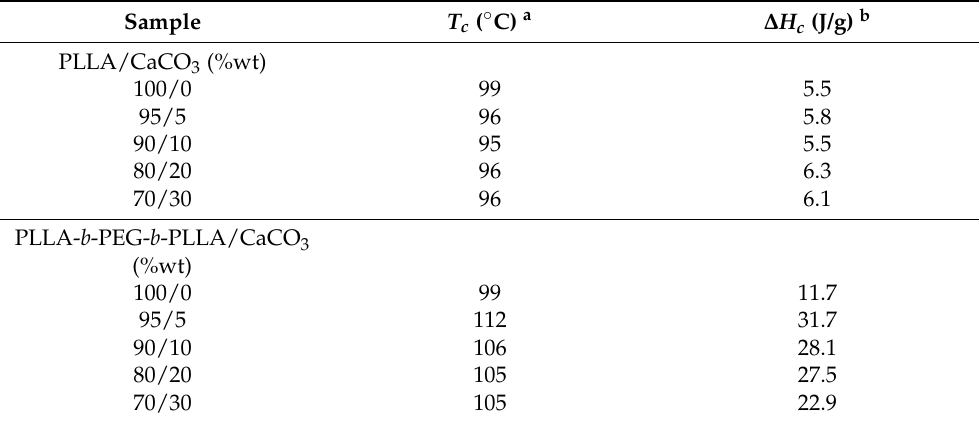
Table 2. Thermal transition properties of the composites from Figure 4.